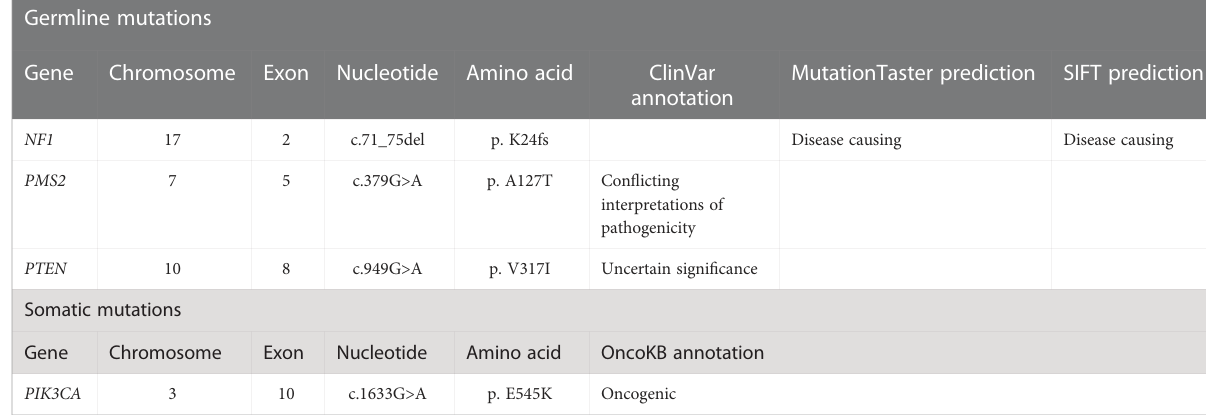
TABLE 1 Genetic test results using the resected formalin fi xed and paraf fi n embedded small bowel adenocarcinoma tumor tissues. Germline